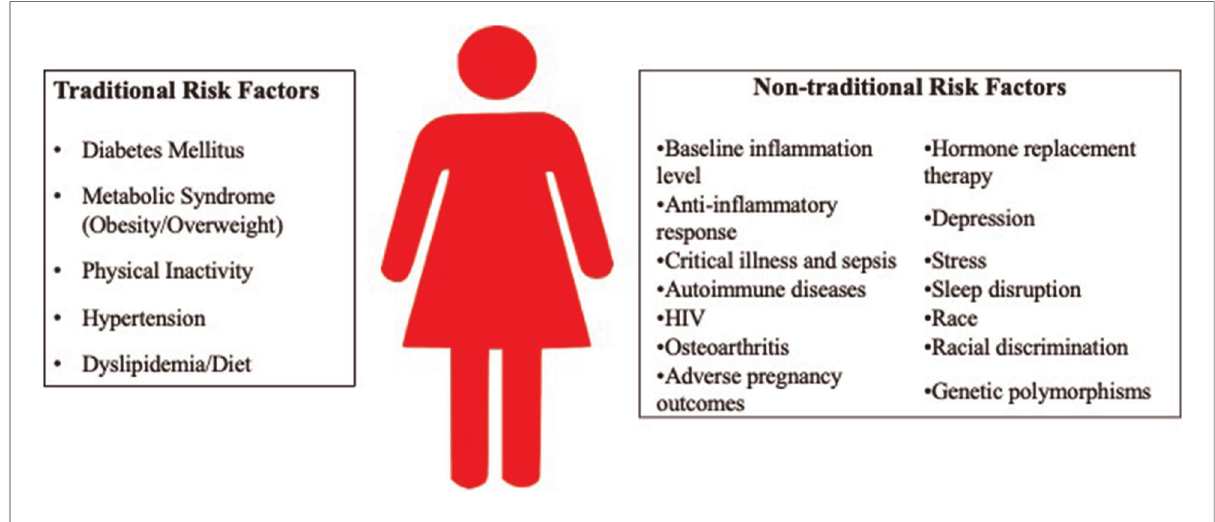
FIGURE 1 Risk factors for cardiovascular disease in